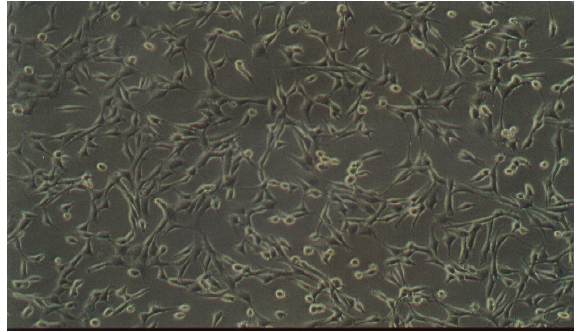
Figure 2. Light micrograph of MAC-T cells showing their characteristic morphology (100 × magnification).